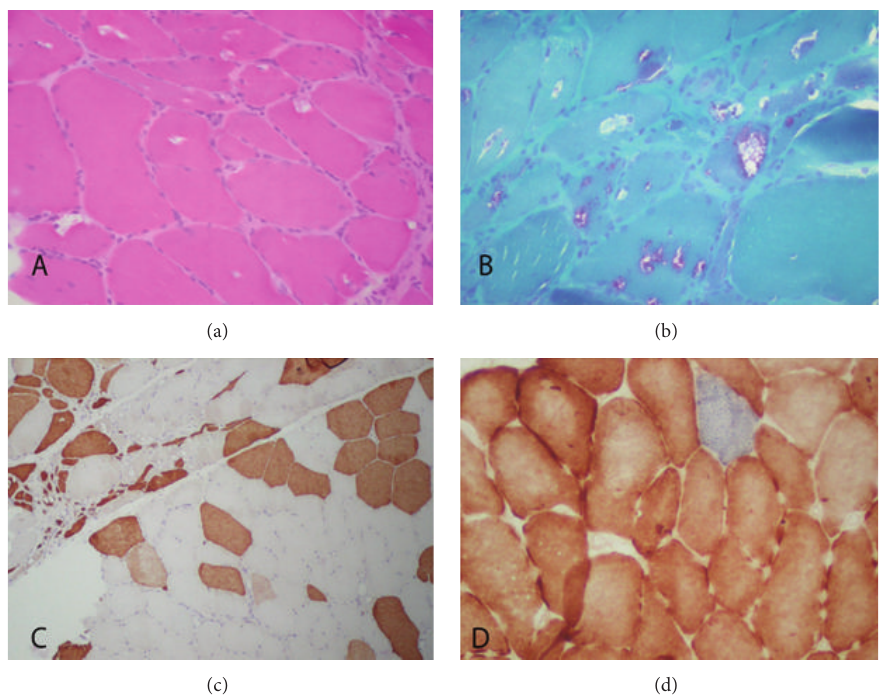
Figure 1: (a) Note the marked variation in fiber size and shape (HE × 200). (b) There are several rimmed vacuoles in the muscle biopsy specimen of Case 1 (Modified Trichrome × 200). (c) Note the plenty of immature fibers with neonatal myosin (DAB × 100). (d) Combined enzyme staining represents normal mitochondrial function (COX+SDH ×